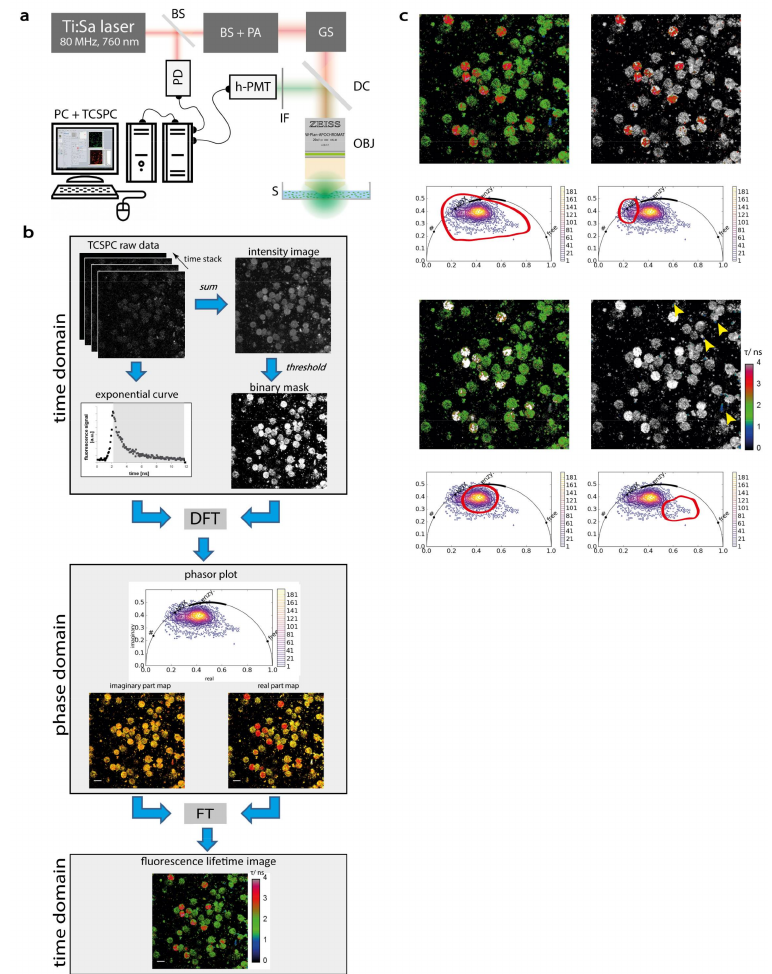
Figure 1. Acquisition and evaluation of NAD(P)H fluorescence lifetime imaging data in cells ( a ) Experimental setup. The beam of a 80MHz pulsed titanium sapphire laser (Ti:Sa) at 760 nm passes a beam shaper (BS), including a telescope and pulse compressor, and a λ /2 plate-based power attenuator (PA). A galvoscanner (GS) scans the beam over the sample (S). The laser beam is focused by a 20 × water immersion NA 1.05 objective (OBJ). Excitation and emission light are separated by a